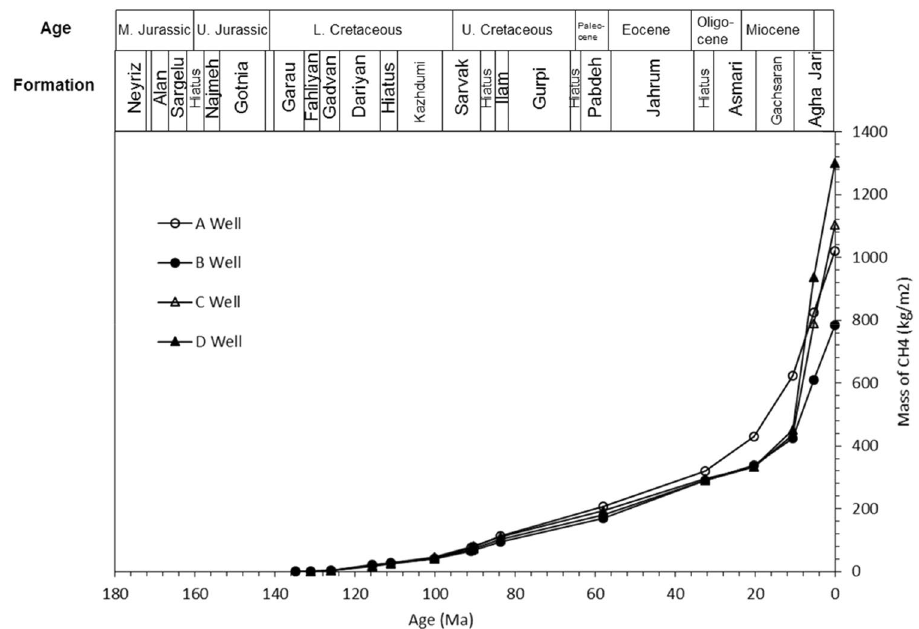
Fig. 18 Mass of methane retained in the Upper Sargelu zone through geological time for Wells A, B, C, and